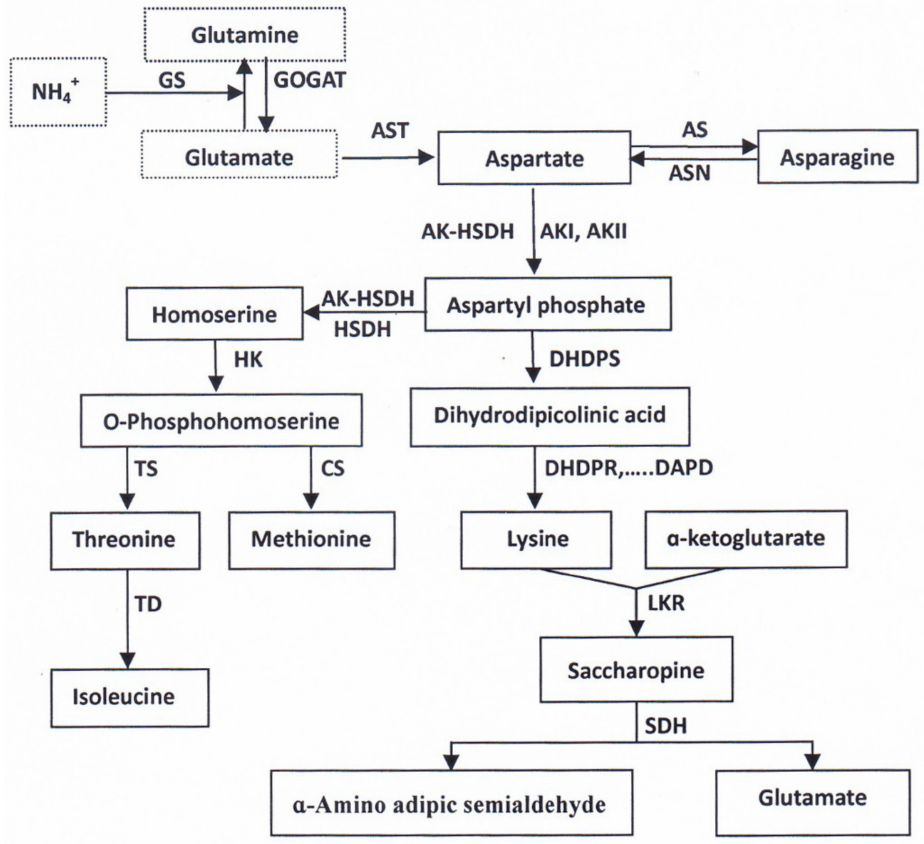
Figure 2. Amino acid metabolic pathway of aspartate family in higher plants. GS, glutamine syn- thetase; GOGAT, glutamate synthase; AST, aspartate transaminase; AS, asparagine synthetase; ASN, asparaginase; AK, aspartate kinase; HSDH, homoserine dehydrogenase; DHDPS, dihydropicoli- nate synthase; HK, homoserine kinase; TS, threonine synthase; CS, cysthationine synthase; TD, threonine dehydratase; DHDPR, dihydropicolinate reductase; DAPD, diaminopimelate decarboxy- lase; LKR, lysine α -ketoglutarate reductase; SDH, saccharopine dehydrogenase. The figure is made according to